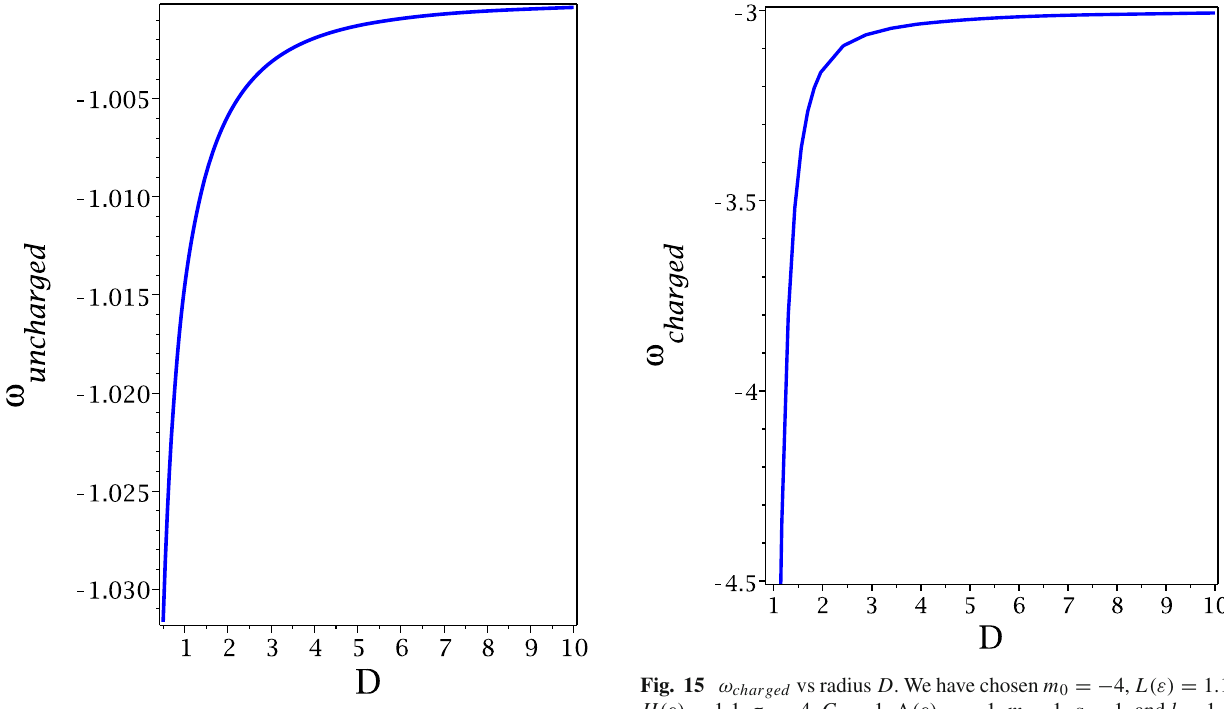
Fig. 14 ω uncharged vs radius D . We have chosen m 0 = − 4, H 0 = 70, A = 1, (cid:8)(ε) = − 1, and H (ε) = 1 . 1